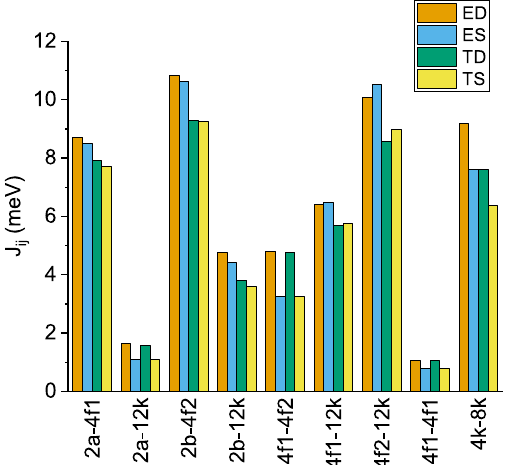
Figure 6. Comparison between the exchange constants obtained under different calculation conditions: experimental lattice under the static (ES) and dynamic (ED) limits, as well as theoretically optimized lattice under the static (TS) and dynamic (TD) limits. All results correspond to the case U = 3